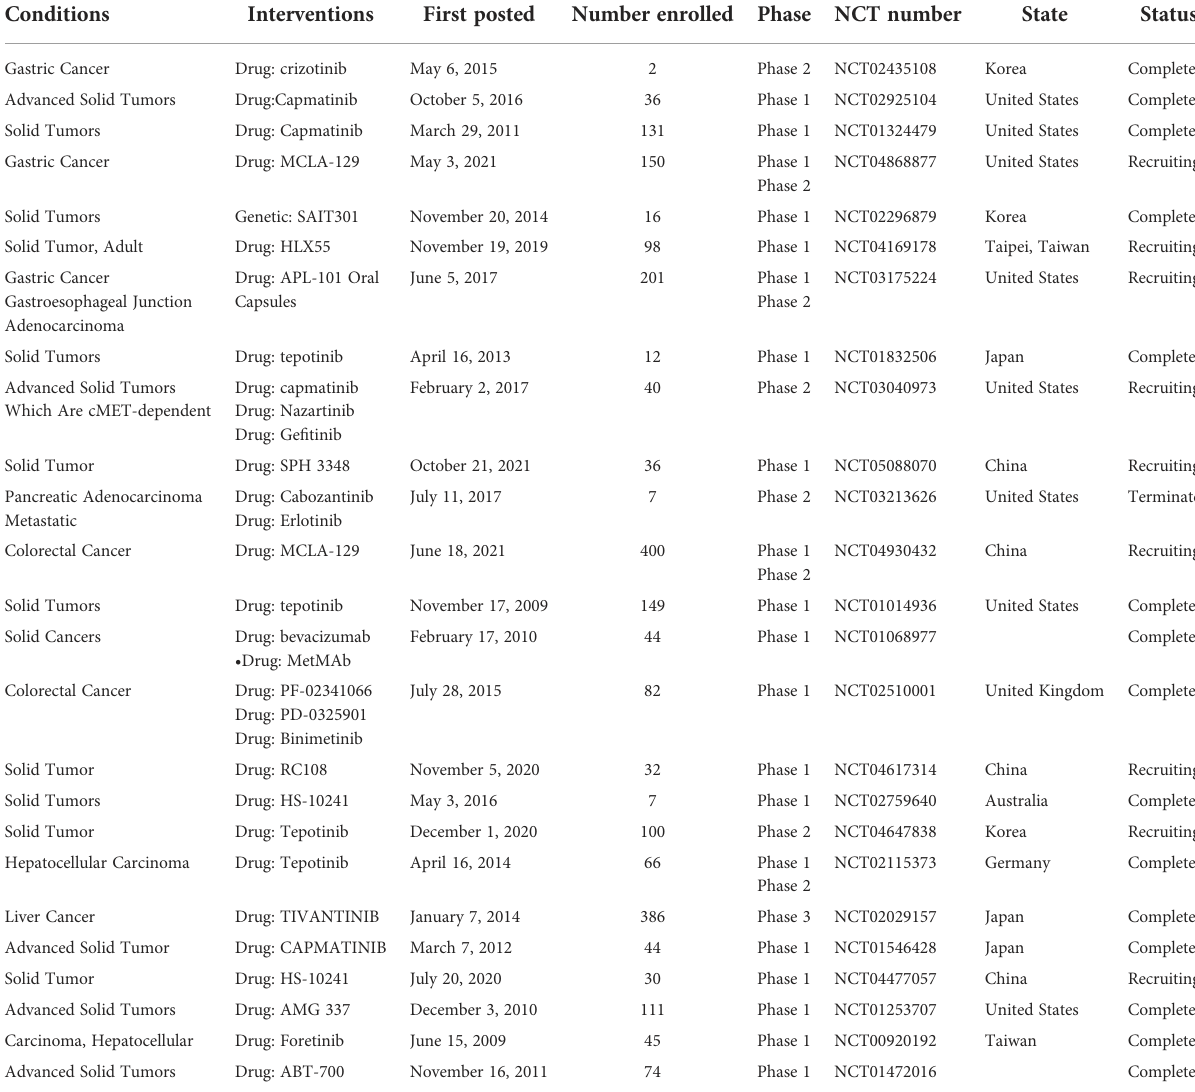
TABLE 1 Clinical studies on c-Met inhibitors in the treatment of DSTs.